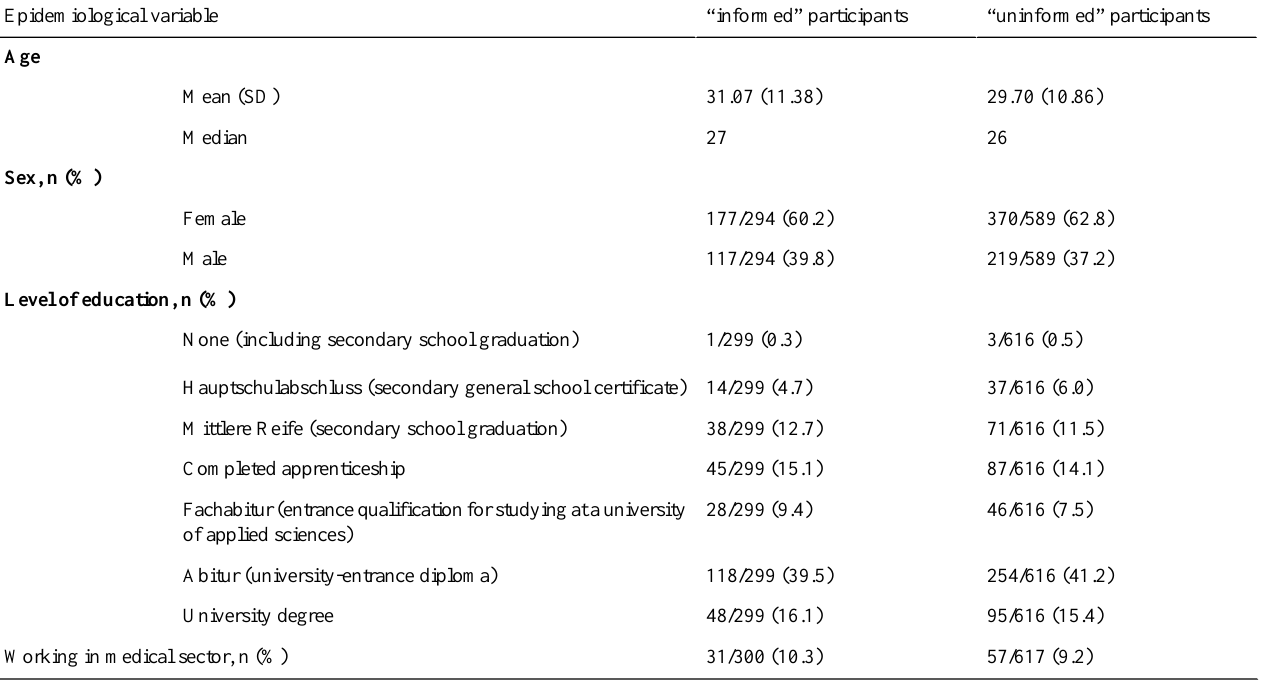
Table 2. Comparison of epidemiological variables between “informed” and “uninformed”